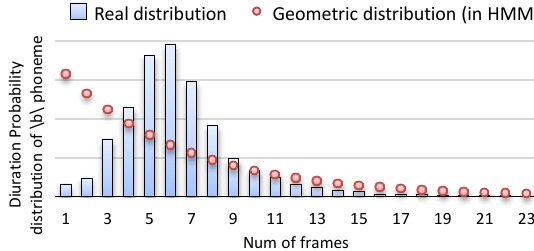
Figure 5. Duration probability distribution for consonant